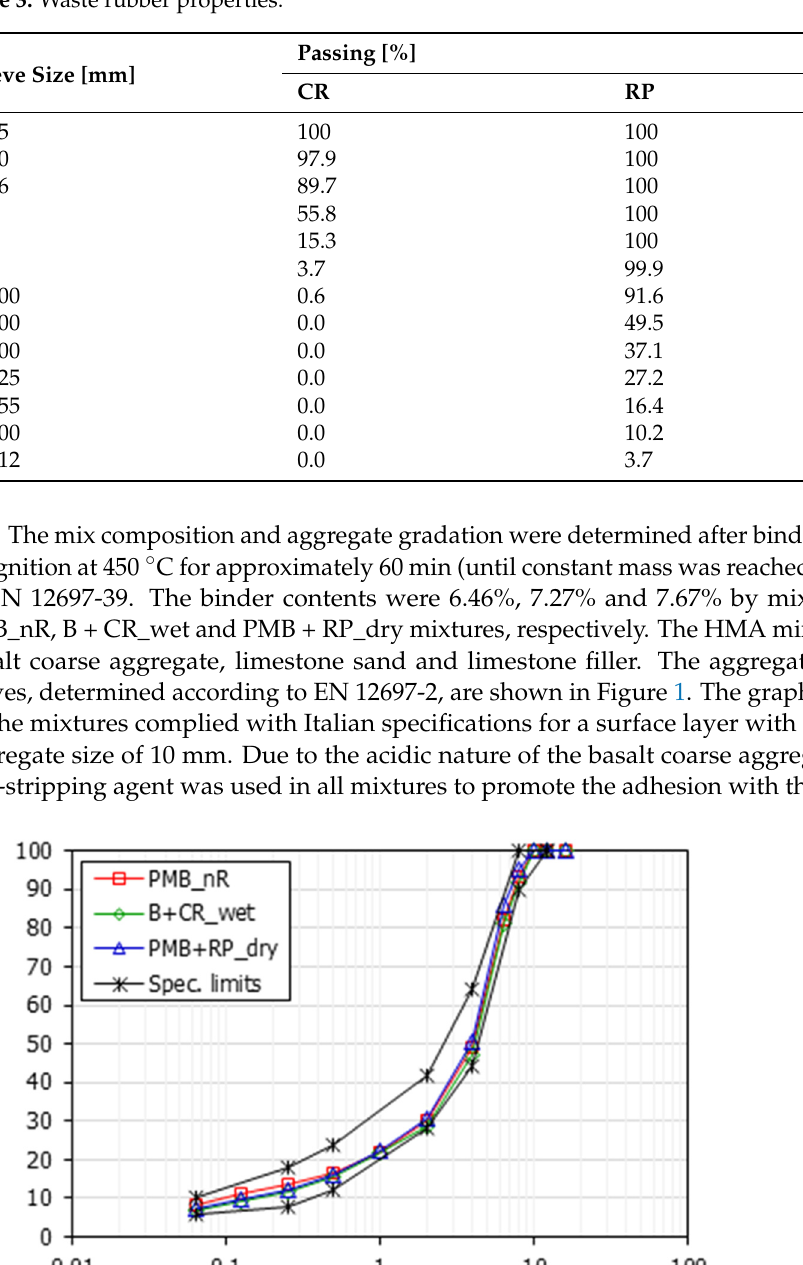
Table 3. Waste rubber properties.